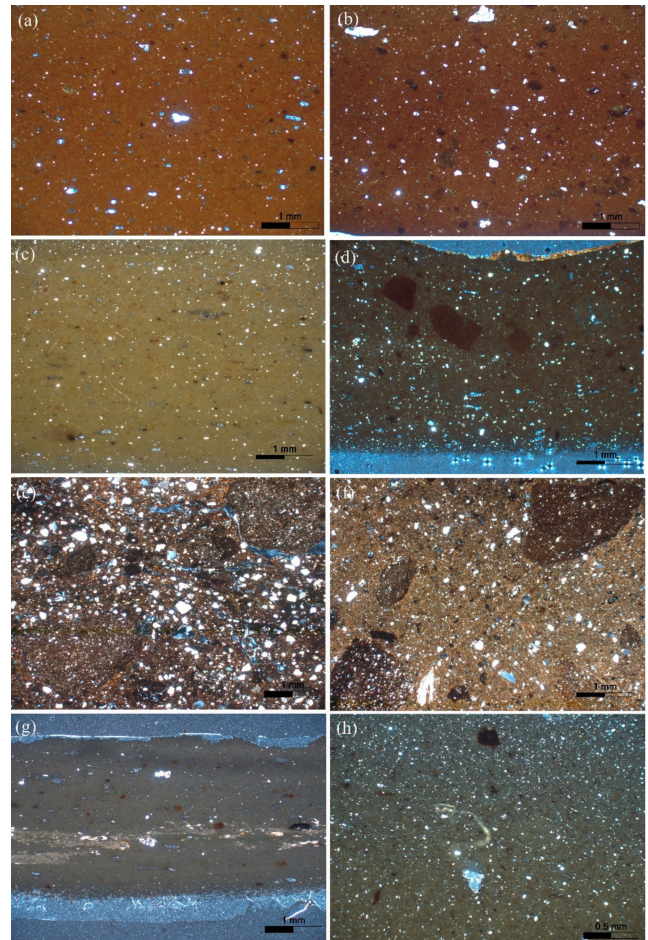
Figure 8. ( a – d ) Representative photomicrographs of the Fine fabric group: Samples K9; K26; K57 and K18, respectively; ( e , f ) representative photomicrographs of the coarse loners: Samples K6 and K16, respectively; ( g , h ) representative photomicrographs of the fine loners: Samples K19 and K23, respectively. All photomicrographs are taken under crossed Nicols